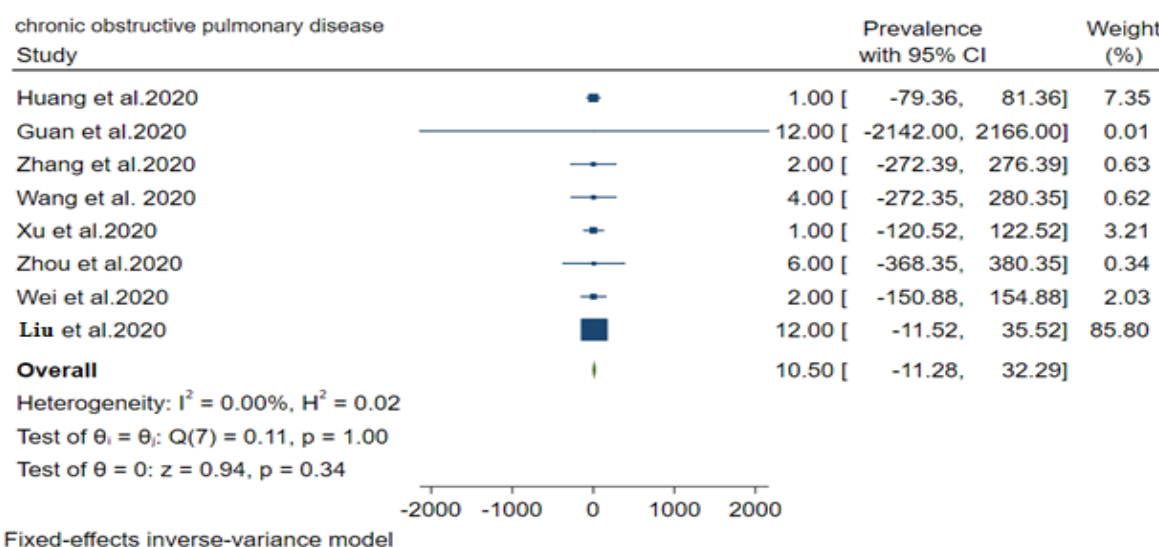
Figure 3. The Funnel plot of the malignancy prevalence among patients with COVID-19.